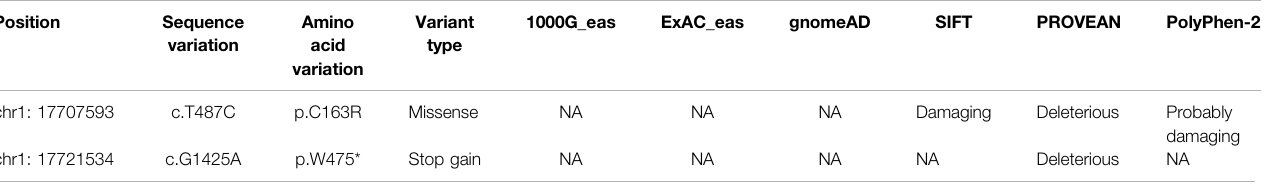
TABLE 1 | Overview of the PADI6 variants identi fi ed from the patients. Position